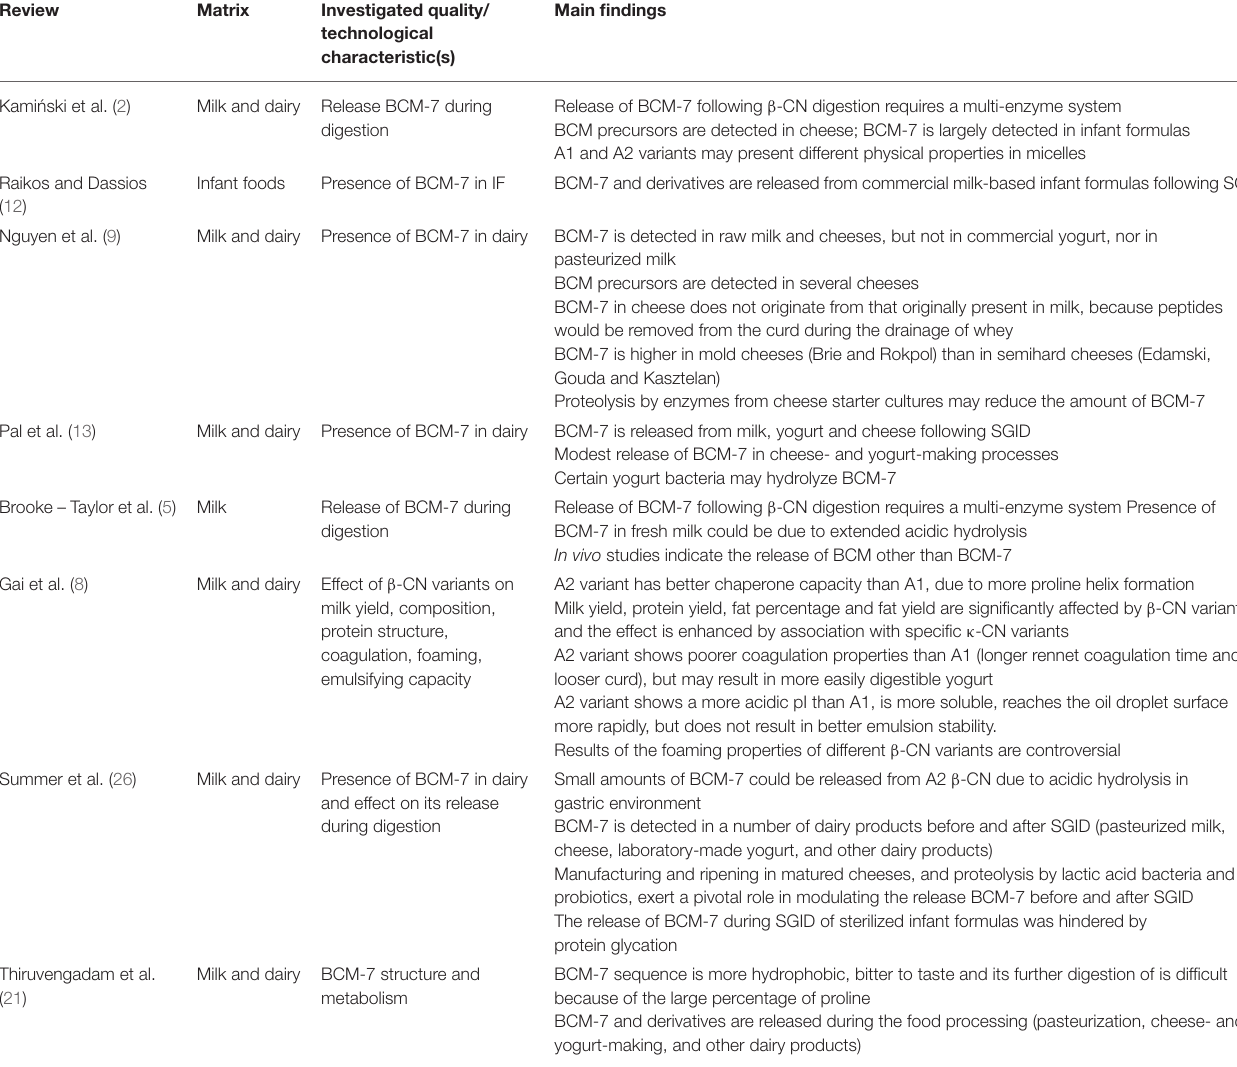
TABLE 2 | List of the retrieved papers concerning physicochemical properties and protein functionality of A1 and A2 β -CN containing milk.